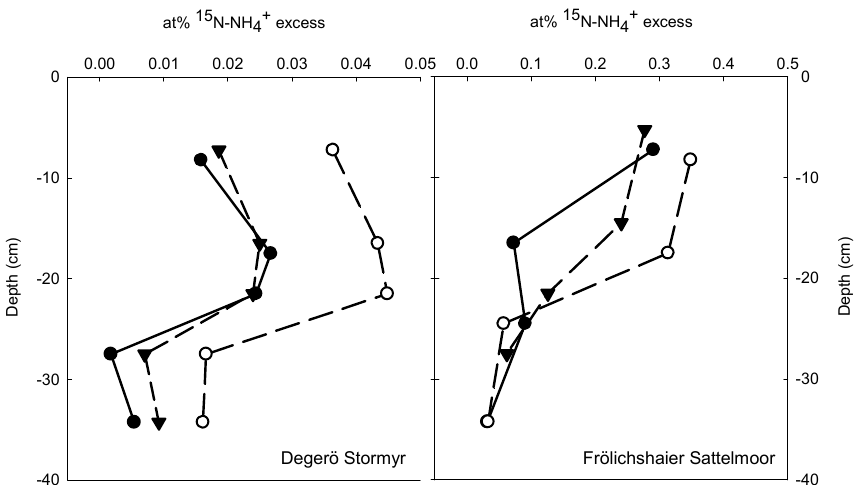
Figure 9. Atomic percent of 15 N-NH + excess in pore water of three replicates from Degerö Stormyr (left) and Frölichshaier Sattelmoor 4 (right). Each symbol in the profile represents the middle depth of the section from which the water was extracted. The scale of the x axes varies across